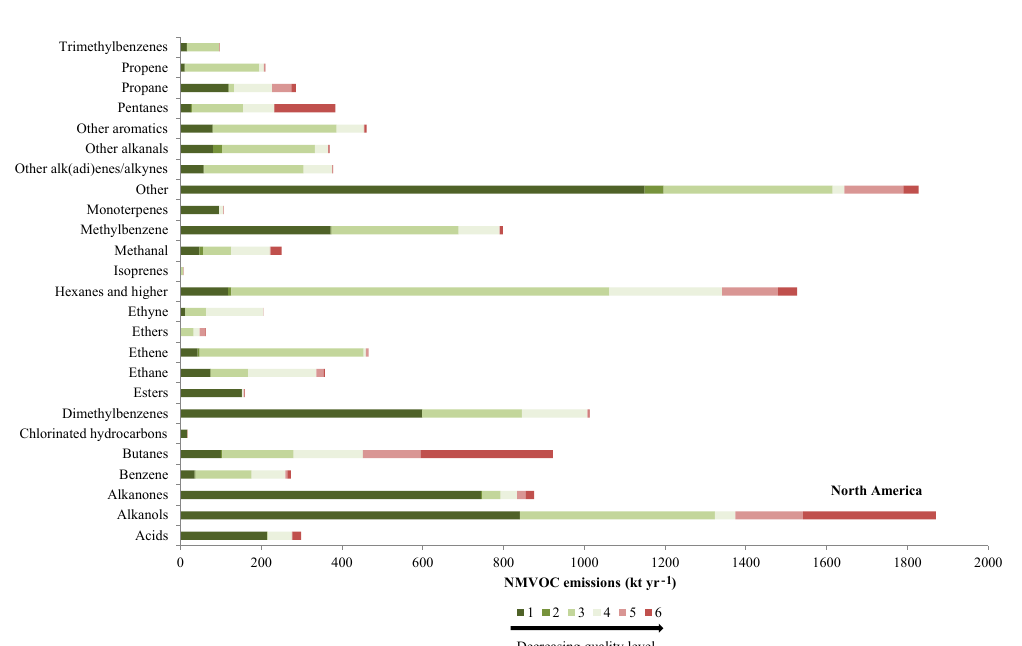
Figure 13. Emissions of 25 NMVOC groups associated with each quality code in 2010 in North